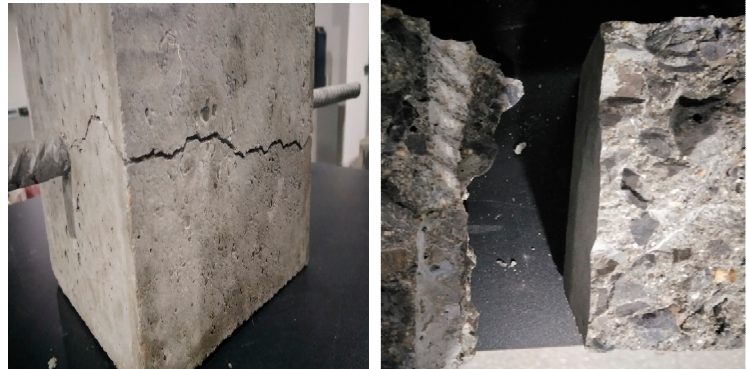
Figure 6. Schematic diagram of cleavage damage.